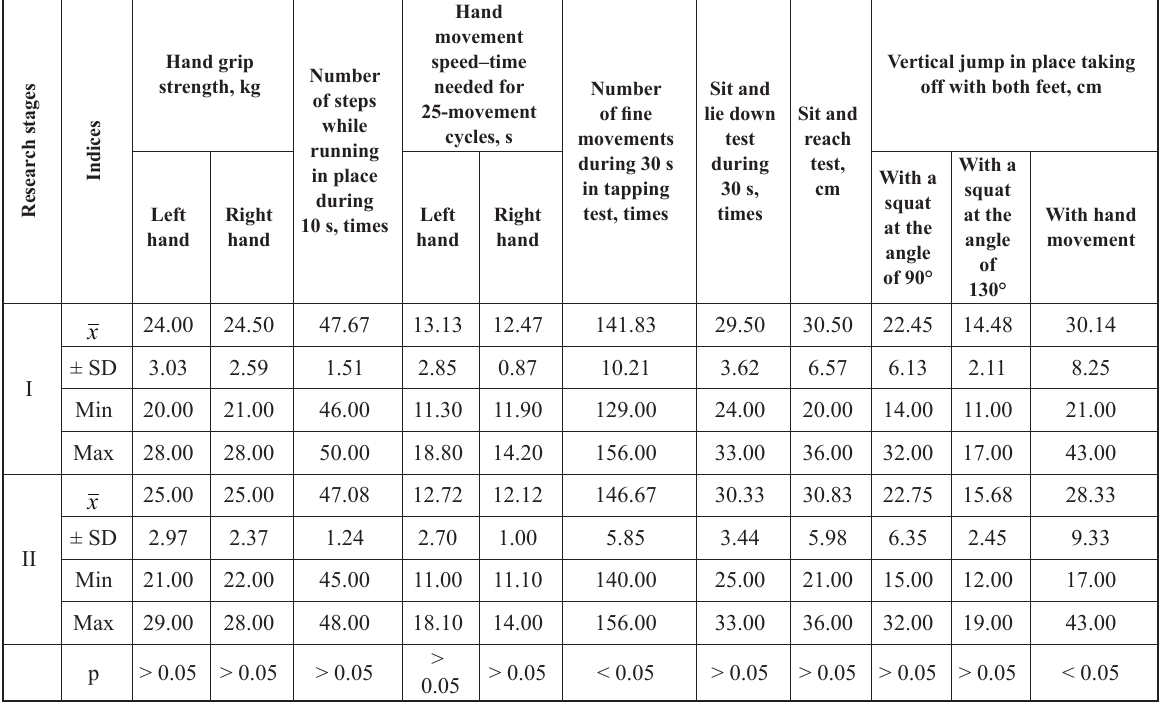
Number of fine movements during 30 s in tapping test, times